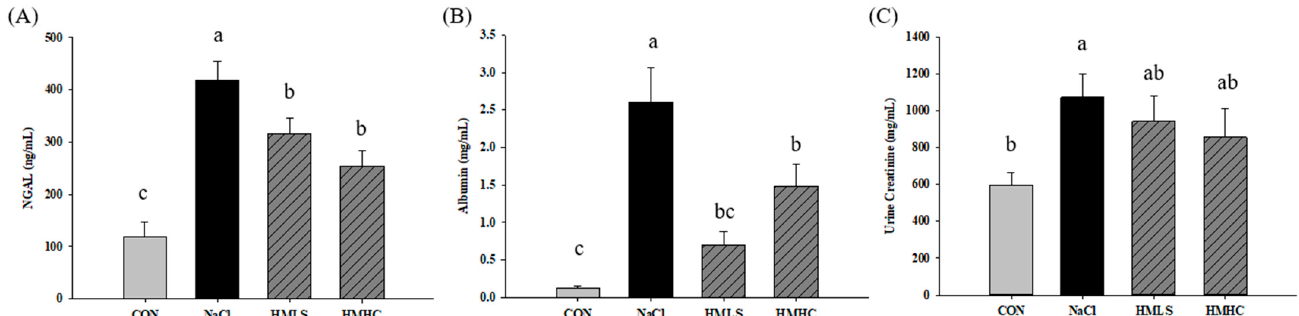
Figure 2. Effects of mineral-balanced DSW on kidney injury markers measured in urine: ( A ) NGAL, ( B ) albumin, and ( C ) creatinine. CON, normal diet + distilled water; NaCl, 8% NaCl diet + distilled water; HMLS, 8% NaCl diet + high magnesium low sodium water; HMHC, 8% NaCl diet + high magnesium high calcium water. Different letters above the bars indicate significant differences (Duncan’s multiple range test; p < 0.05).